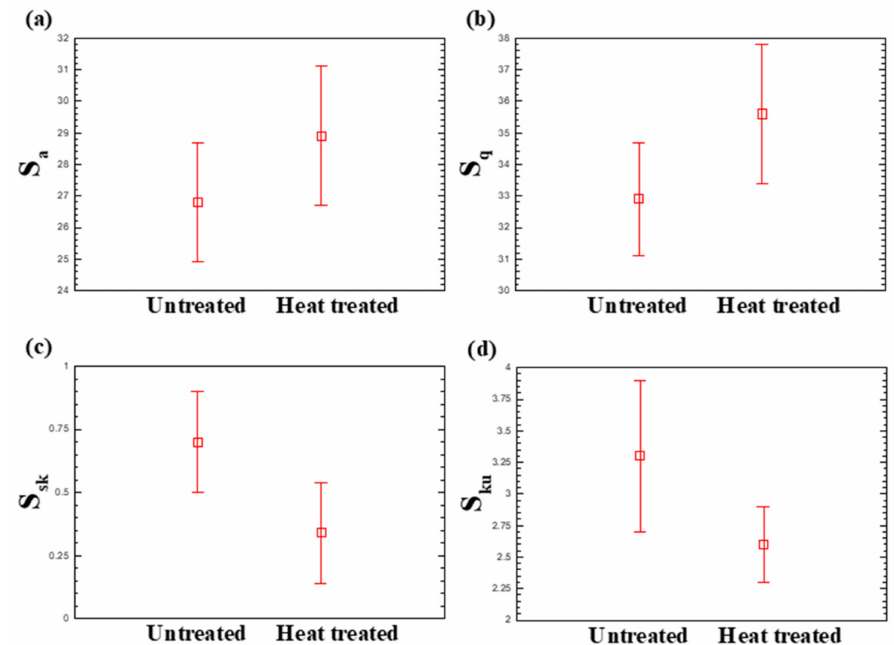
Figure 5. 3D surface texture parameters, including ( a ) S a , ( b ) S q , ( c ) S sk , and ( d ) S ku , for untreated and heat-treated Ti64